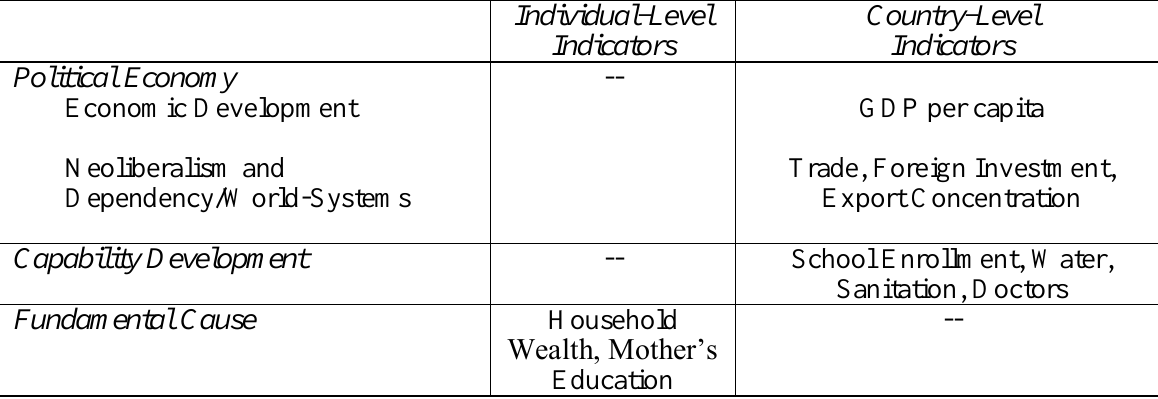
Table 1. Competing Perspectives on Child